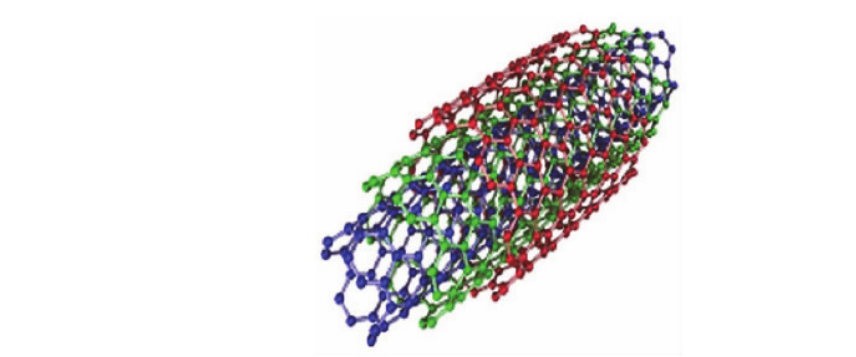
Figure 1: The schematic diagram of carbon nano-tubes structure.